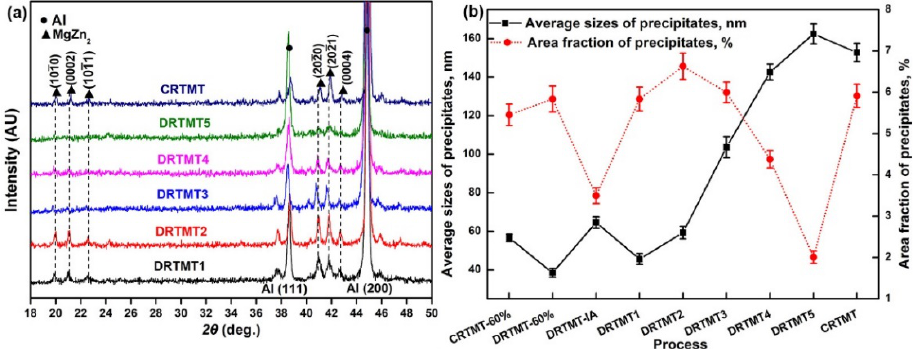
Figure 8. ( a ) XRD spectrum; ( b ) the average sizes and fractions of precipitates after the final hot deformation. hot